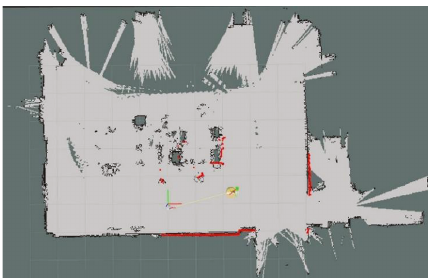
Figure 9: Map of localization experiment. Table 1: Result of straight line round-trip motion experiments. Robot Error of original Origin ’ s pose